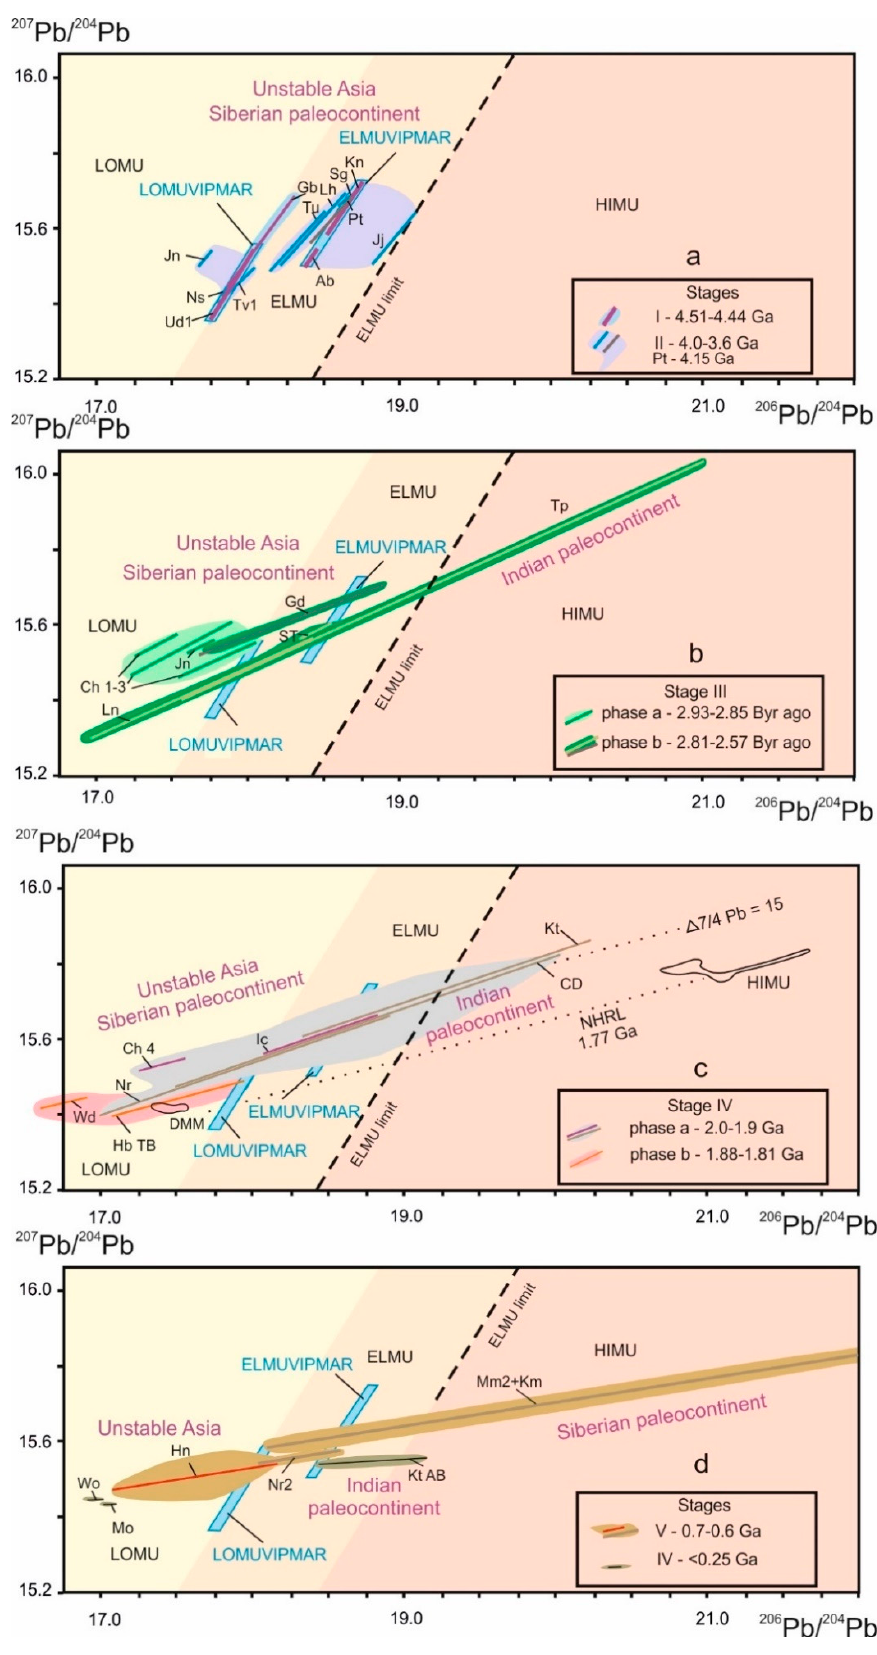
Figure 14. Mantle stages of Asia in summary diagrams of Pb isotopic data for sources of late Phanerozoic melting anomalies of unstable Asia and stable Siberian and Indian paleocontinents. Location of melting anomalies is indicated in Figure 1. The LOMUVIPMAR and ELMUVIPMAR compositions and LOMU – ELMU and ELMU limit the discriminating lines are plotted as in Figure 5.